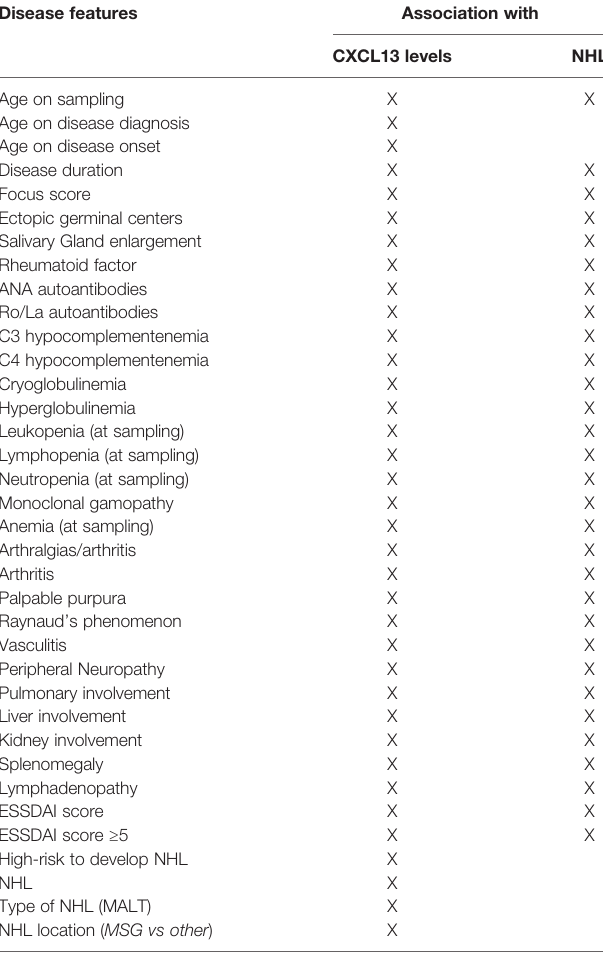
TABLE 2 | Demographic, histologic, laboratory and clinical features of pSS patients that were evaluated for association with the serum, saliva or MSG levels of CXCL13 or